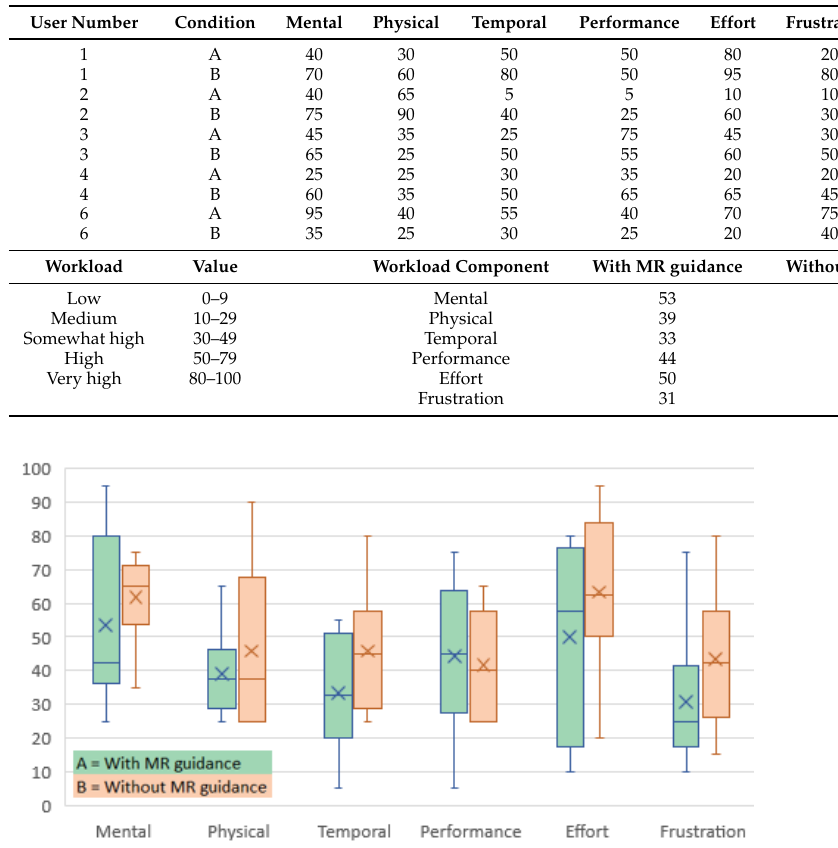
Table 3. NASA-TLX questionnaire results for the six study participants (engineering students) in two conditions: With MR guidance (A) and without MR guidance (B).